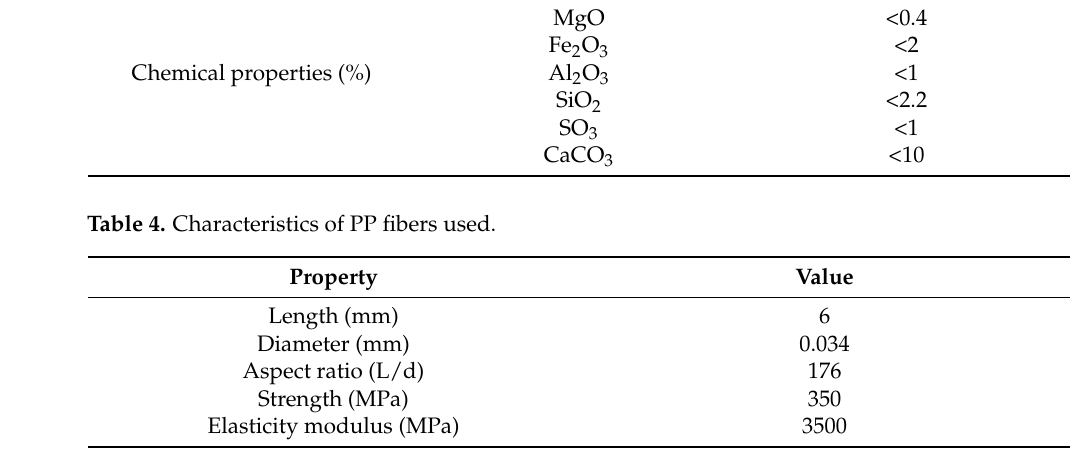
Table 4. Characteristics of PP fibers used.